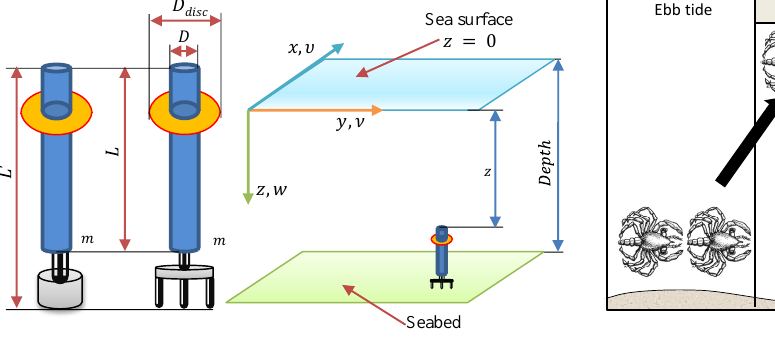
Figure 4: Diagram of blue crab post-larvae migration using Selective Tidal-Stream